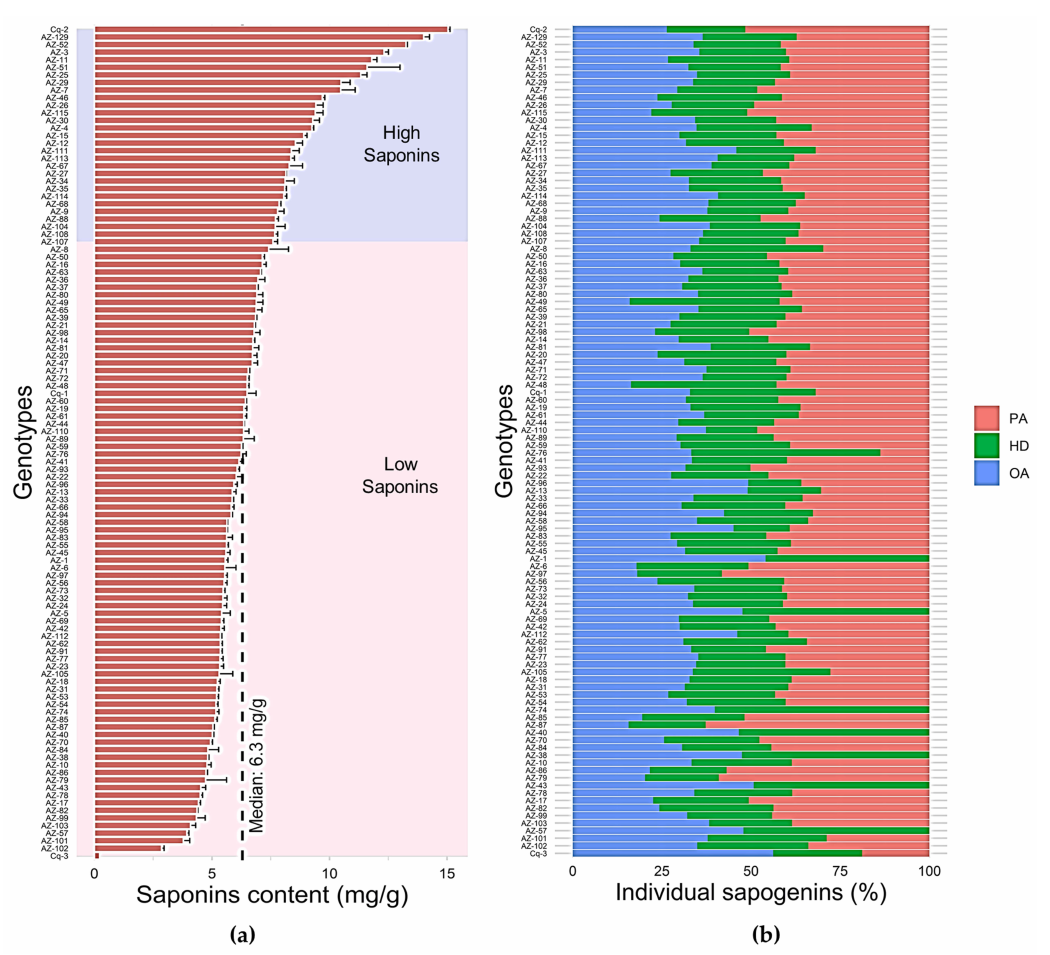
Figure 2. Total saponin content ( a ) and percentage of individual sapogenins ( b ) in the C. quinoa panel. ( a ) A bar graph showing relative saponin content in different C. quinoa accessions. Quantification of saponins was indirectly performed via their corresponding sapogenins. Analyzed data are reported as mean ± standard deviation of independent sample extractions. Statistical analysis was performed by ANOVA test (Tukey’s ± HSD, α = 0.05). A significant difference ( p < 0.001) in relative saponin content was noticed and saponins concentration ranged from 0.22 mg/g to 15.04 mg/g of seed DW. The median line shows the average of the total saponin content of all studied genotypes. ( b ) Stacked bar graph showing individual sapogenins and outlined in % of total saponins. Light blue: Oleanolic acid (OA), Green: Hederagenin (HD), and Light red: Phytolaccagenic acid